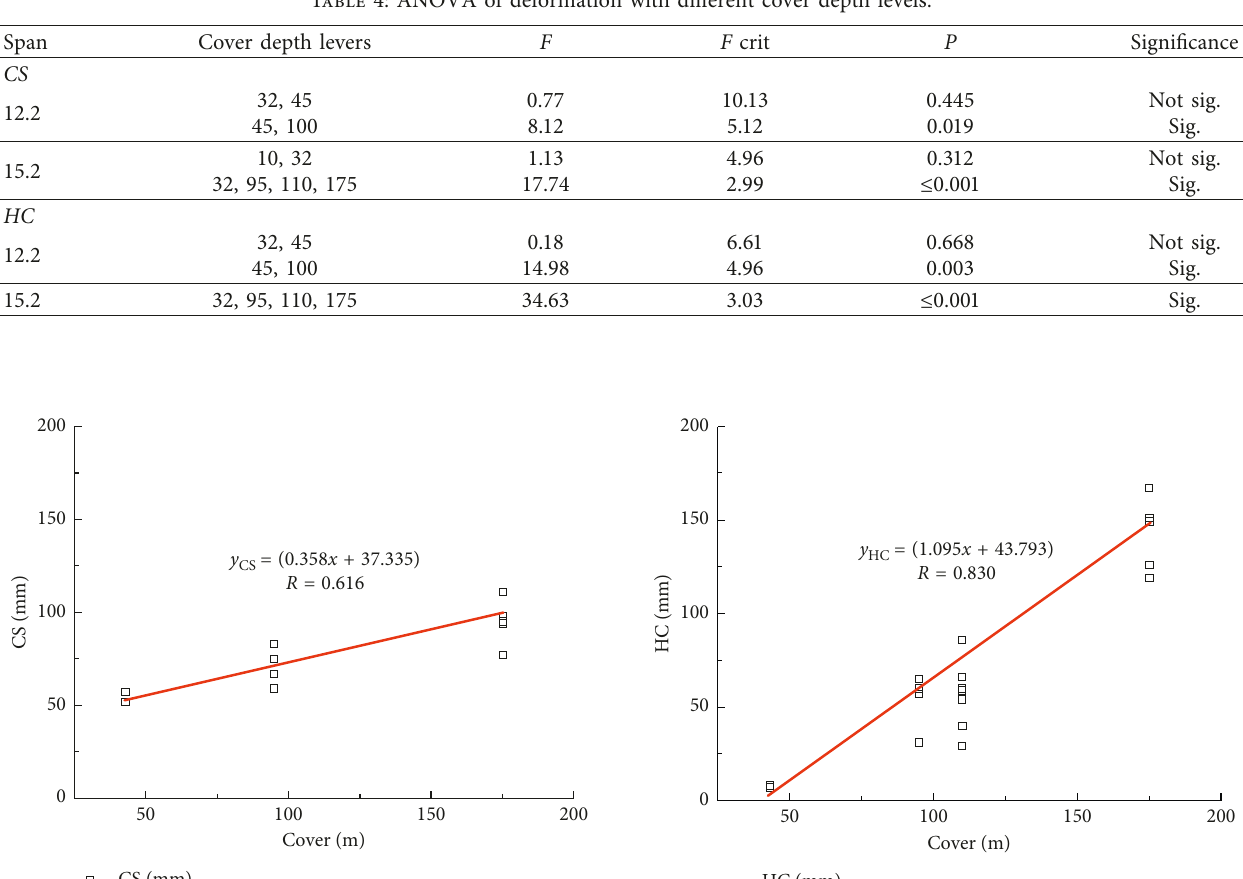
Table 4: ANOVA of deformation with different cover depth levels.